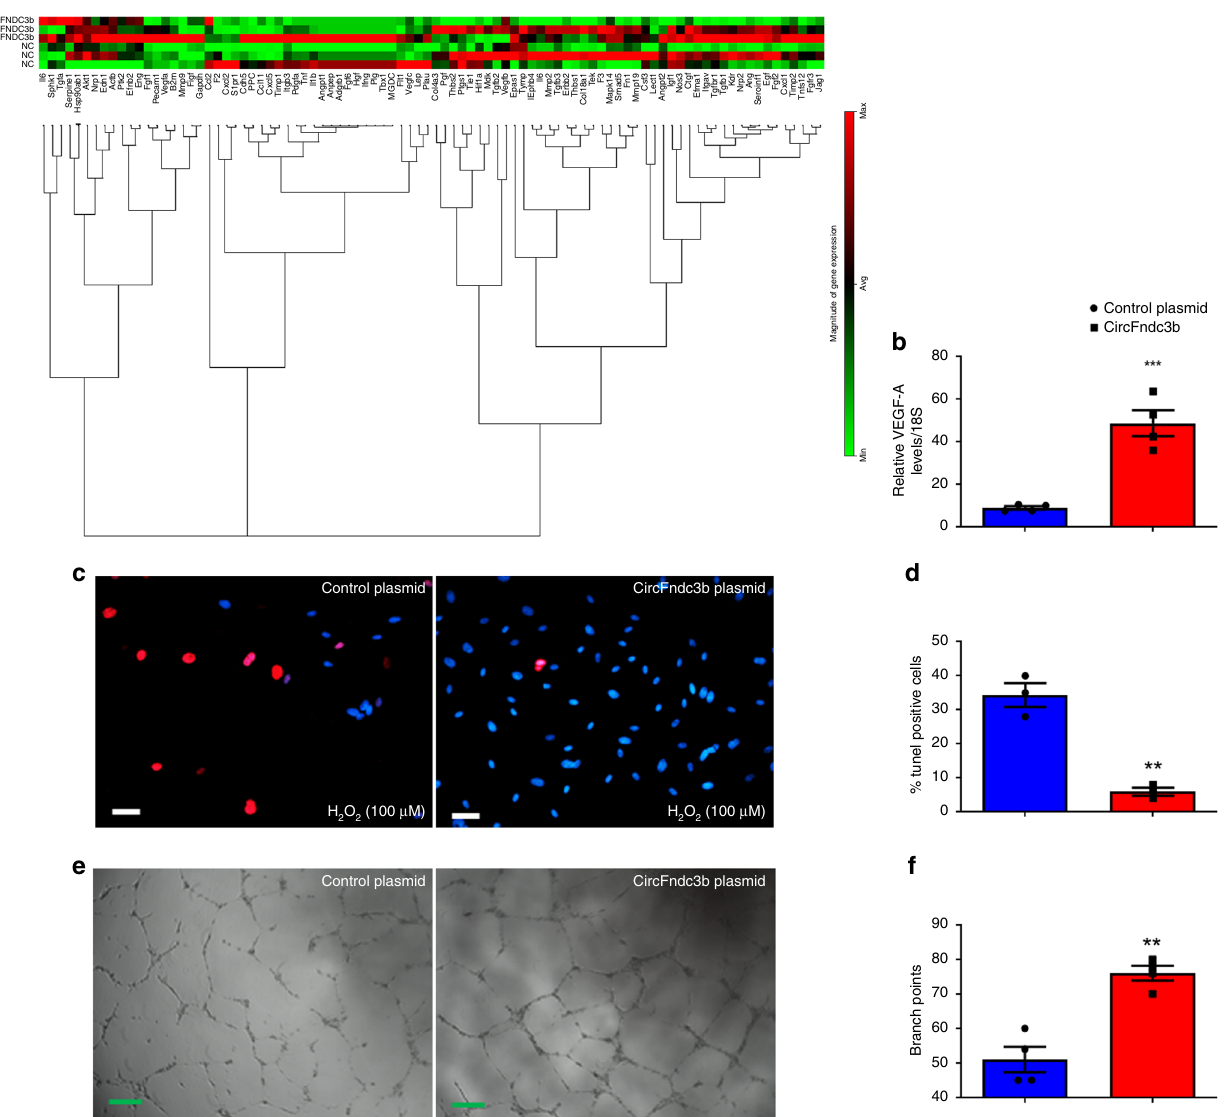
Fig. 3 Overexpression of circFndc3b enhances endothelial cell function in vitro: a Heat map showing differentially expressed genes in control plasmid or circFndc3b overexpression plasmid-treated MCECs based on RT-PCR angiogenesis array. N = 3 independent experiments/group; b RT-qPCR validation of VEGF-A expression in control plasmid and circFndc3b overexpression plasmid-treated MCECs, data normalized to 18S rRNA. Data are Mean± SEM of four independent experiments/group. *** p < 0.001 vs plasmid control (two-sided unpaired students t-test). c , d Representative photomicrographs (100 μ m) of TUNEL staining in control plasmid or circFndc3b overexpression plasmid-treated endothelial cells. Quanti fi cation of TUNEL + cells presented as the % TUNEL-positive cells and DAPI-stained nuclei. Data are Mean ± SEM of three independent experiments/group. ** p < 0.01 vs plasmid control (two-sided unpaired students t-test); e Representative photomicrographs (200 μ m) of tube formation in control or circFndc3b overexpression plasmid-treated HUVECs; f Quanti fi cation of branch points. Data are Mean ± SEM of four independent experiments/group. ** p < 0.01 vs control plasmid (two-sided unpaired students t